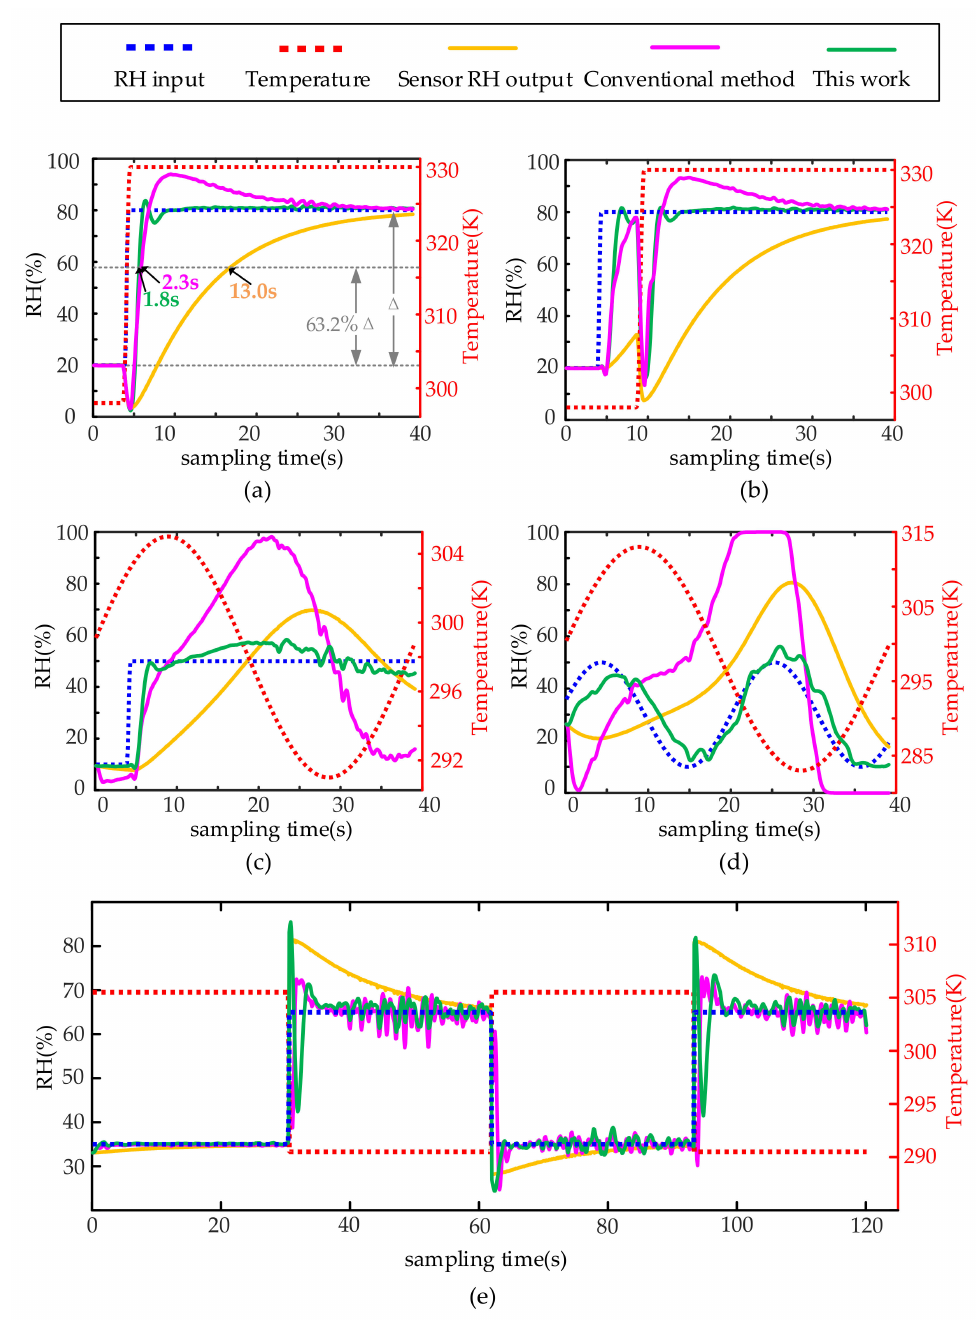
Figure 10. Simulation compensation results for not-constant temperature: ( a ) simultaneous step change in ambient temperature and humidity, ( b ) time-division step change in ambient temperature and humidity, ( c ) periodic change in ambient temperature and humidity step change, ( d ) the ambient temperature and humidity change periodically at the same time, ( e ) several consecutive temperatures and humidity environment switching